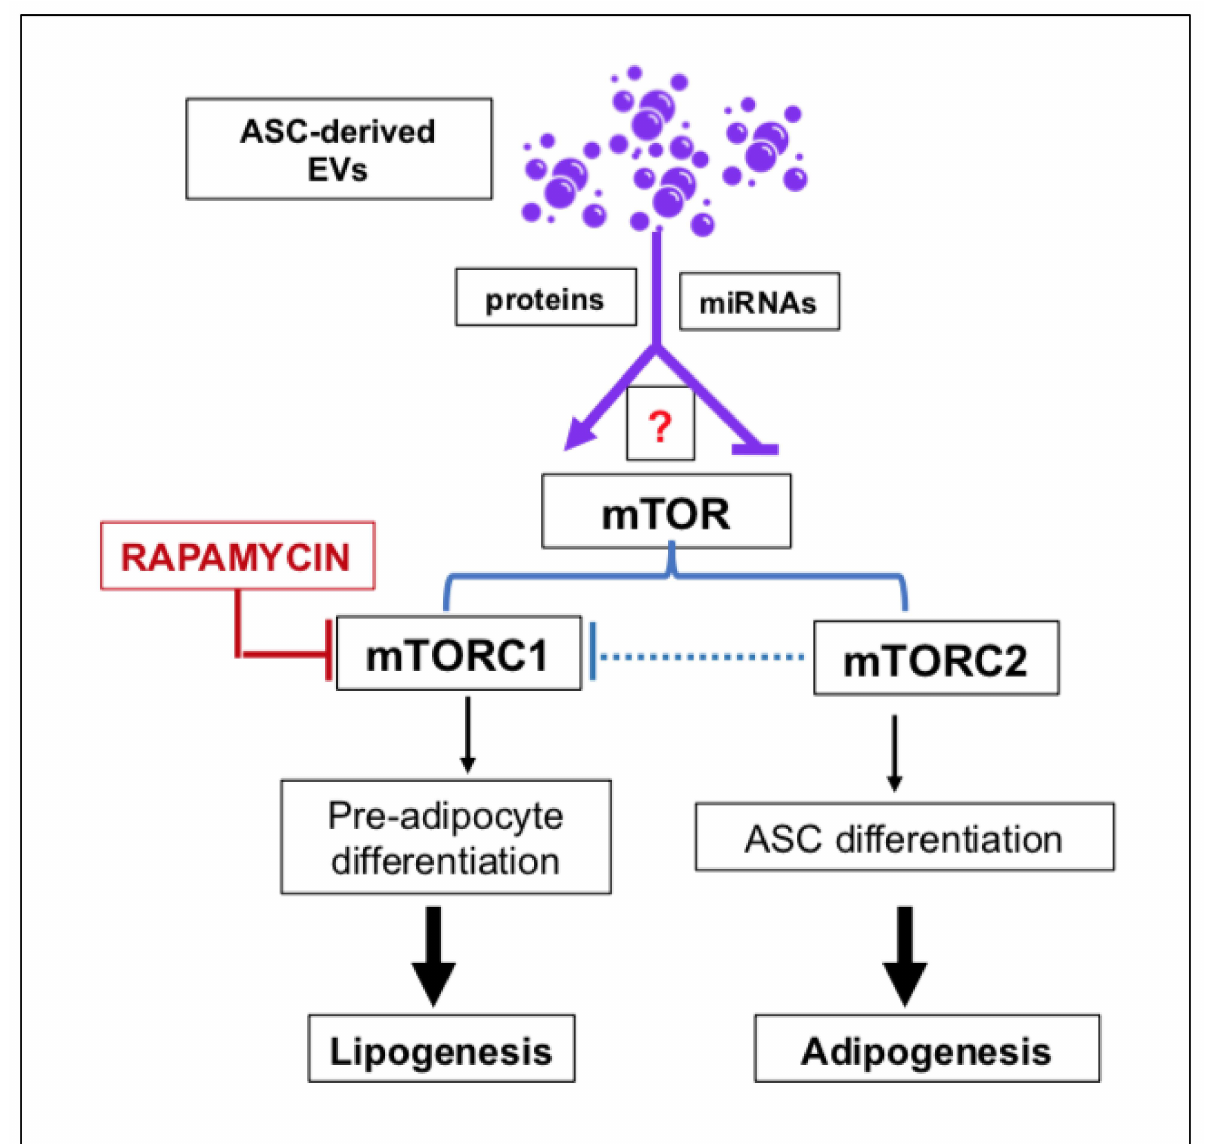
Figure 3. ASC-derived EVs could exert a modulatory role on the activity of the two components (mTORC1 and mTORC2) of the mTOR system in cells of the white adipose tissue (WAT) through the release and donation of selected molecules (miRNAs, proteins). The arrow drawn with a dotted line indicates that mTORC2 modulates mTORC1 (cid:48) s function, probably inhibiting it. The red question mark indicates that EV-mediated activities have yet to be defined in adipocytes. Abbreviations: ASCs, adipose stromal/stem cells; EVs, extracellular vesicles; miRNAs, microRNAs. However, this effect was time-dependent. Indeed, only long-term blockade of mTORC1 by rapamycin can reduce DIO in mice [90]. In contrast, it has been reported that the pretreat- ment of human ASCs with the same drug enhanced autophagy, while reducing apoptosis, delaying senescence, promoting adipogenesis of those cells in vitro and increasing their survival and angiogenesis in vivo [91]. These effects could be explained by the greater sensitivity of mTORC1 to inhibition by rapamycin, which leads to the prevalent activity of mTORC2 (Figure 3). In this scenario, it would also be desirable to investigate which and how much of these effects are mediated by molecules donated from ASC-derived EVs to neighboring cells through the involvement of the mTOR